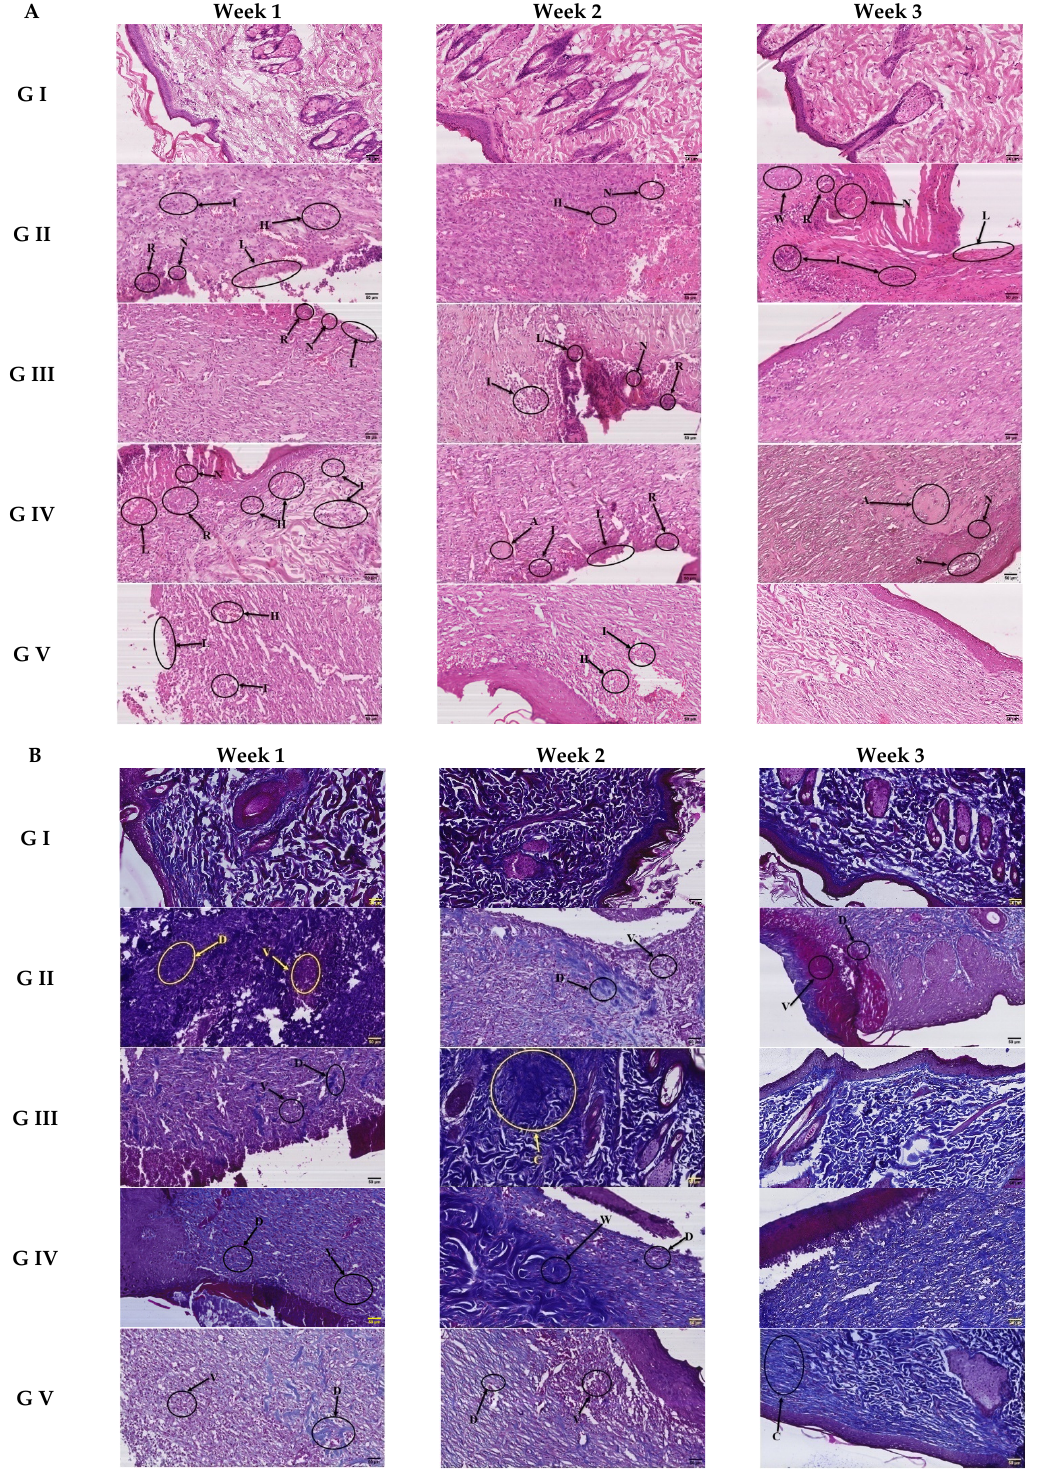
Figure 11. Photographs of H&E-stained sections ( A ) and Masson trichrome (MT) for connective tissue fibers ( B ). L= loss of epithelial tissue layer area, R = epithelialization area, W = normal epithelial tissue area, N = Necrotic tissue area, I = infiltration of inflammatory cells, A = accumulation of hyaline material, S = Separation area remaining (H&E, 200×, Bar = 50 µm), D = decreased amount of collagen fibers, V = very much decreased amount of collagen fibers, C = collagen fibers reformation after wound healing, W= normal appearance of collagen fibers, (MT, 200×, Bar = 50 µm).